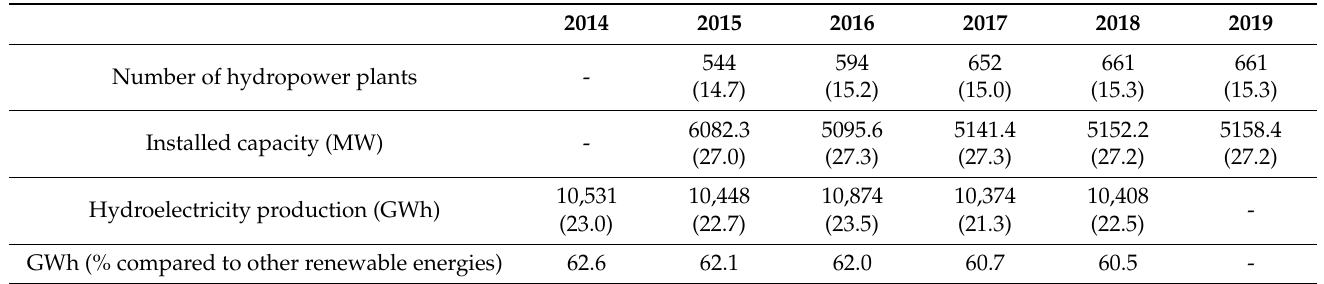
Table 2. Hydropower in Lombardy from 2015 to 2019 (data from [25–29]). The percentage compared to Italy is reported within